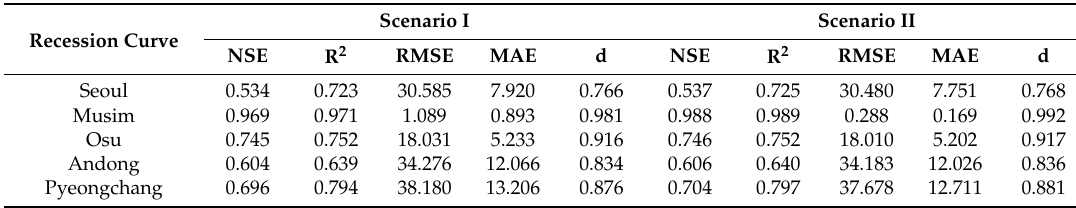
Table 4. Comparison of streamflow recessions for Scenarios I and Scenarios II for study